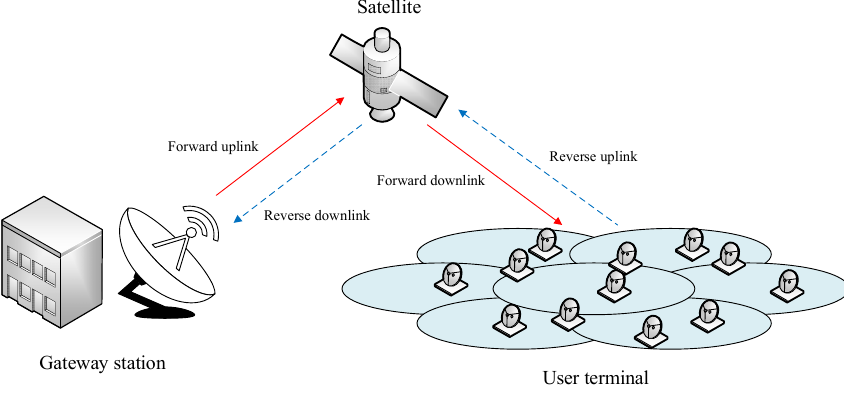
Figure 1. Forward link and reverse link of high-throughput satellite system.